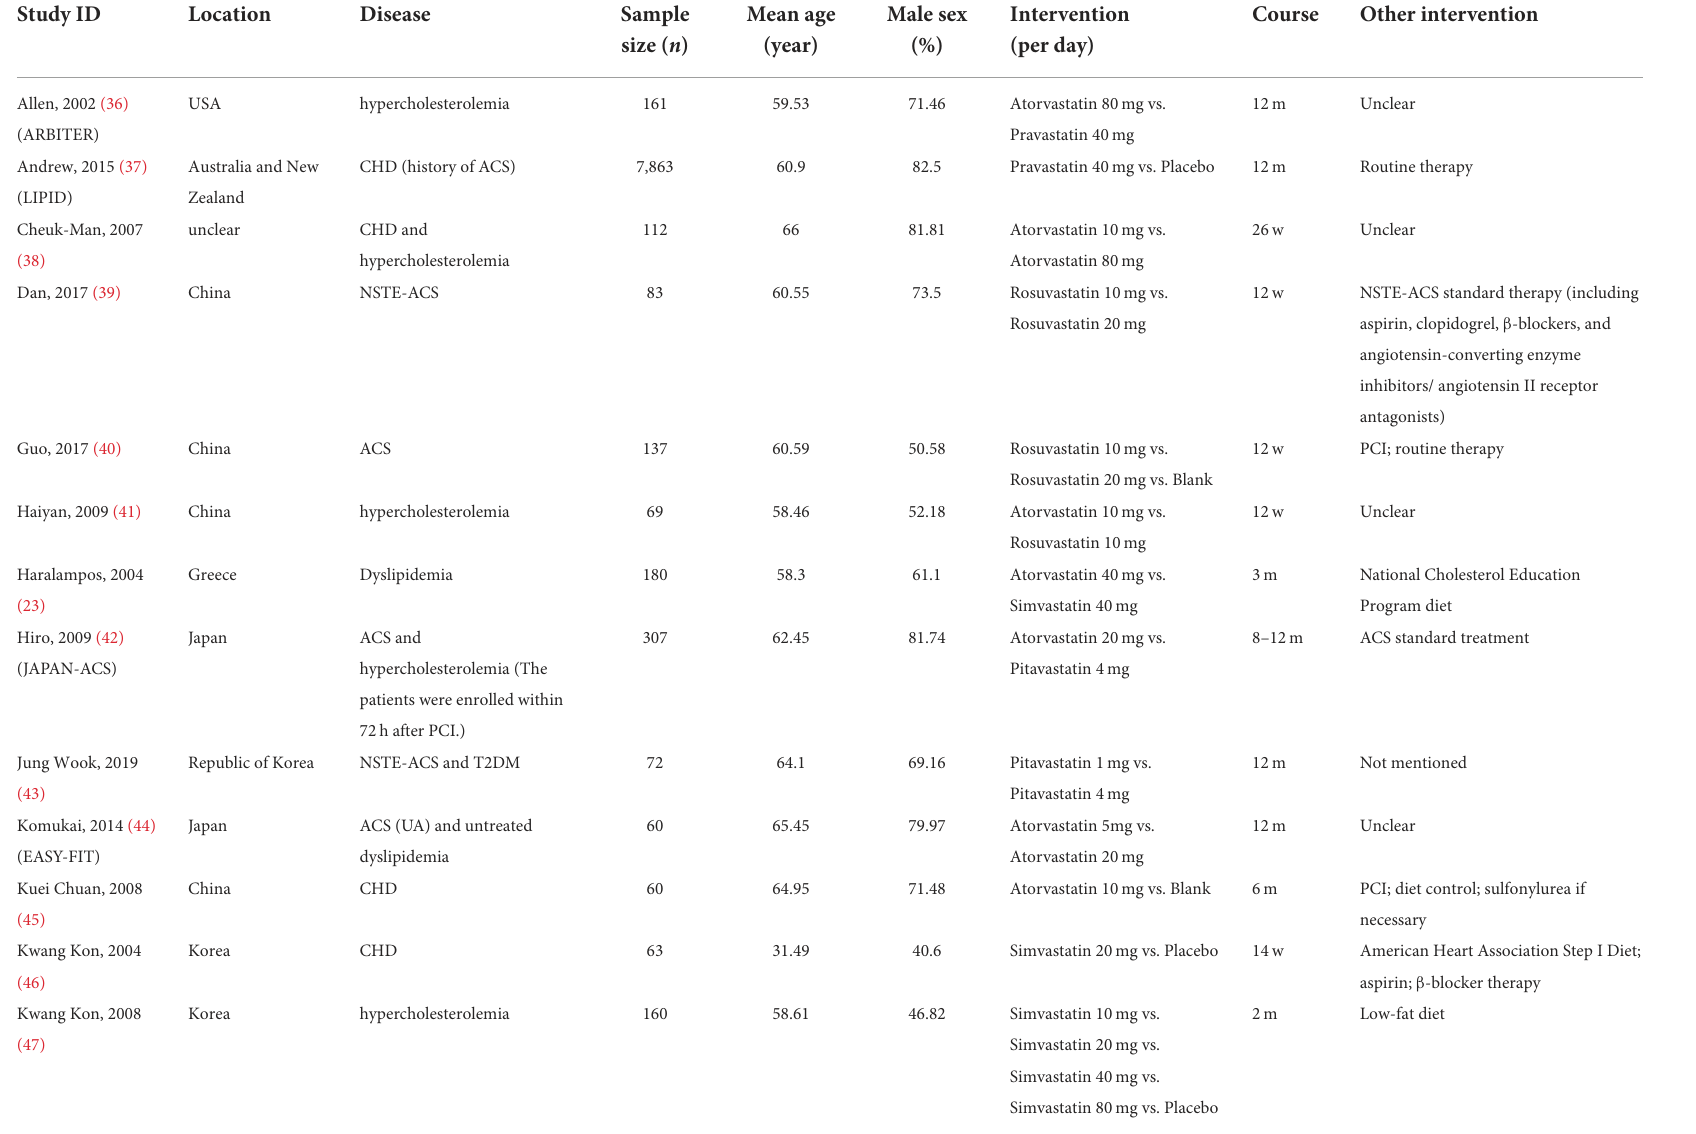
TABLE 1 Baseline characteristics of the included